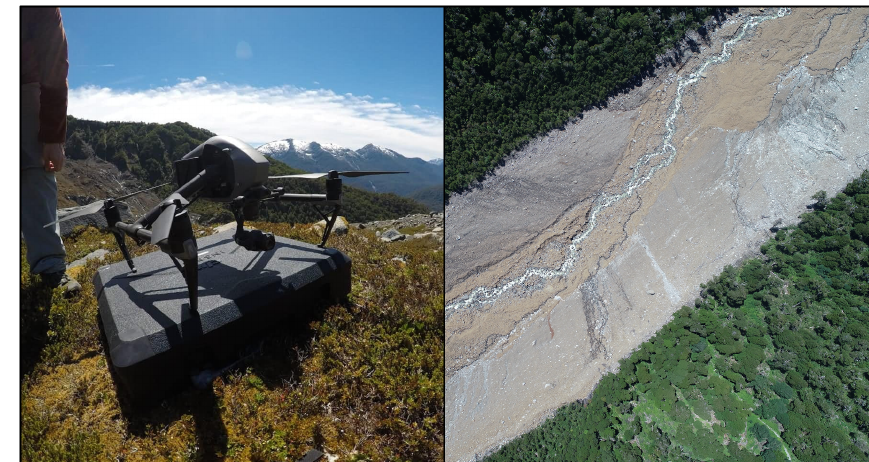
Figure 5. UAV mapping survey.